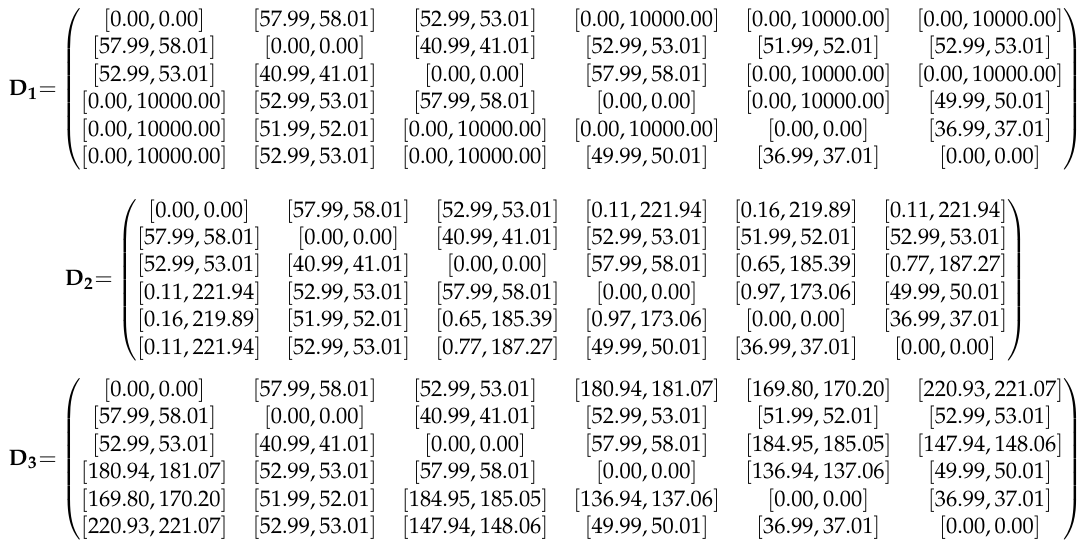
Figure 9. D 1 stands for the matrix of input ranges as provided by the infrared sensors; D 2 , for the matrix of ranges after imposing triangular inequalities; and D 3 , the matrix of ranges resulting from applying the method introduced in this paper.